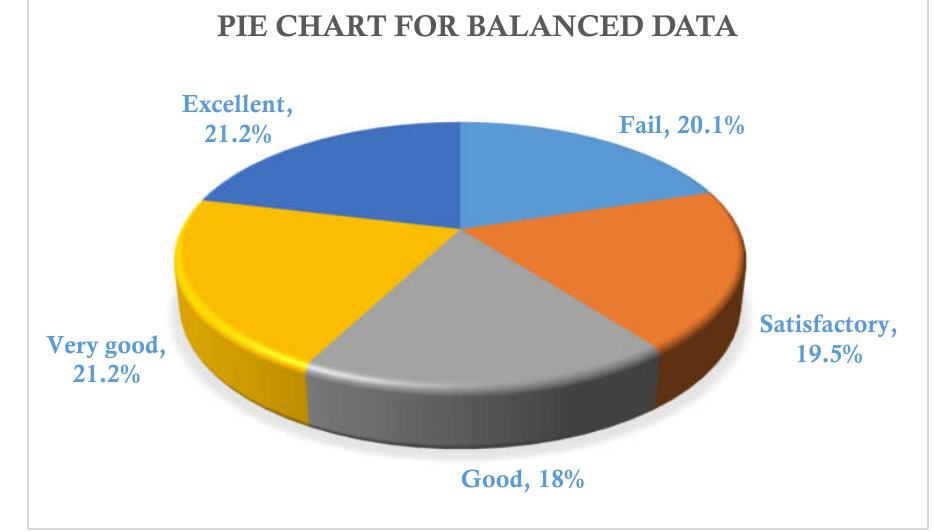
Figure 5. Percentage of students based on grade level (balanced data).